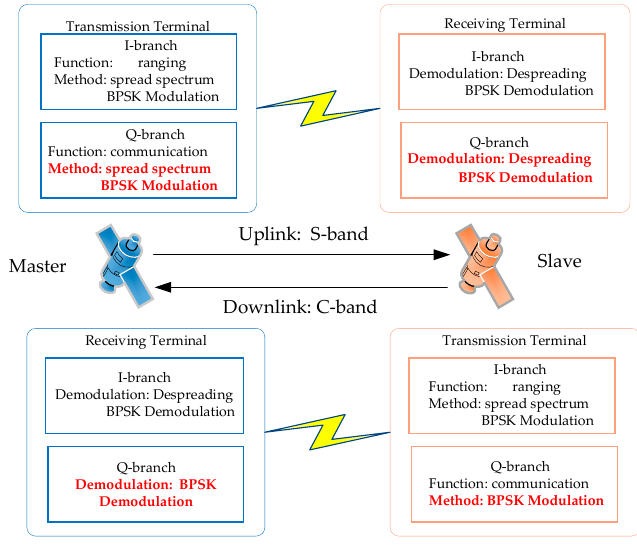
Figure 2. System model of simultaneous ranging and communication in Master/Slave mode.